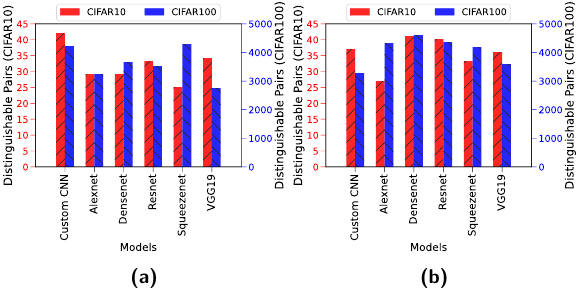
Figure 3: Number of distinguishable class pairs using timing side-channel in different CNNs on CIFAR10 (out of 45) and CIFAR100 (out of 4950) on (a) Intel Xeon and (b) Intel i7